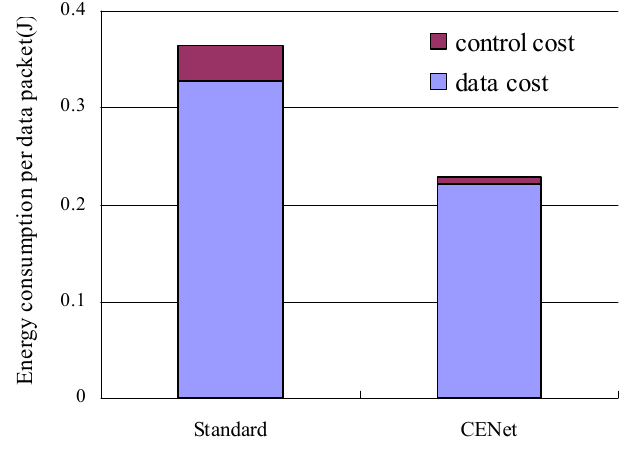
Figure 13. The energy consumption of CENet is 38% less than that of standard stack and the energy consumption for control packets in CENet is 85% less than that in standard